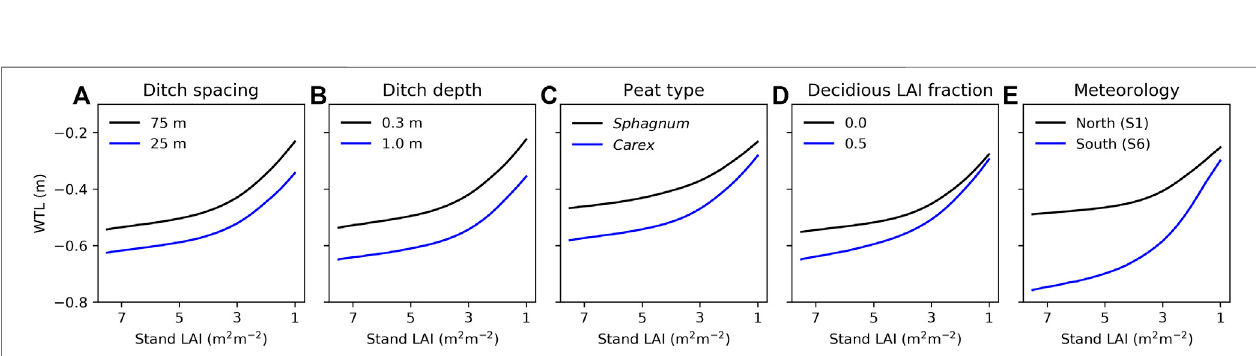
FIGURE 8 | Model predicted impact of (A) ditch spacing, (B) ditch depth, (C) peat type, (D) deciduous trees fraction of stand leaf area index (LAI), and (E) meteorology on water table level (WTL) in relation to stand LAI. The ranges of the varied parameters (A – D) are set based on their variability in sites S1 – S6, while other parameters correspond to the values presented in Table 2 and forcing is from site S3, except in (E) where forcing is varied from the northernmost to the southernmost site. WTL is the mean value for July – October during 2014 – 2019. Note that stand LAI decreases along the x-axis, describing increasing cutting intensity.